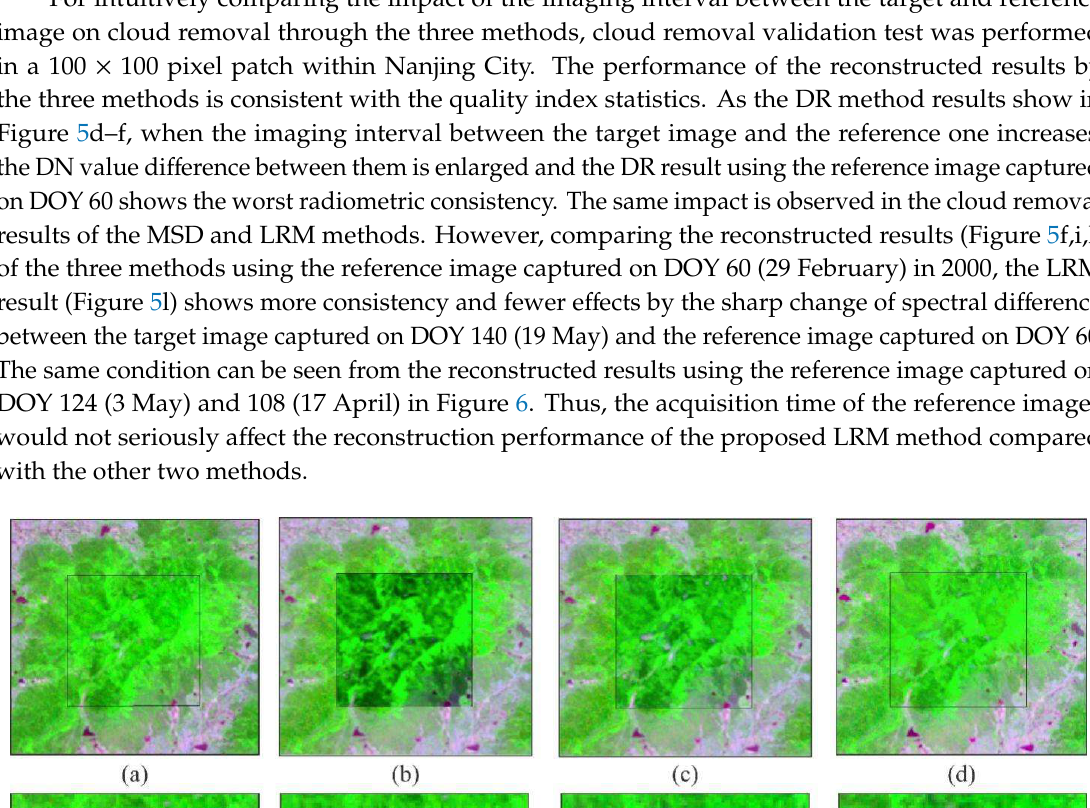
Figure 6. Reconstruction of the target TM image captured on DOY 140 using the three approaches with the reference image captured on DOY 124 in the mountain area (bands 1, 4 and 3 composited). ( a ) The target image captured on DOY 140 in the mountain area with 100 × 100 pixels (inside the black line). ( b )-( d ) The reconstructed images by DR, MSD and LRM methods using the reference image captured on DOY 124 for 100 × 100 pixel (inside the black line) cloudy patch. (e) The irregular size cloudy patch (inside the black line) of the target image captured on DOY 140 over the mountain area. ( f )-( h ) The reconstructed images by DR, MSD and LRM methods using the reference image captured on DOY 124 for the irregular size cloud. Cloud masks with cloudy pixels (inside black line) set to 0 and cloud-free pixels (outside the black line) assigned as 1.